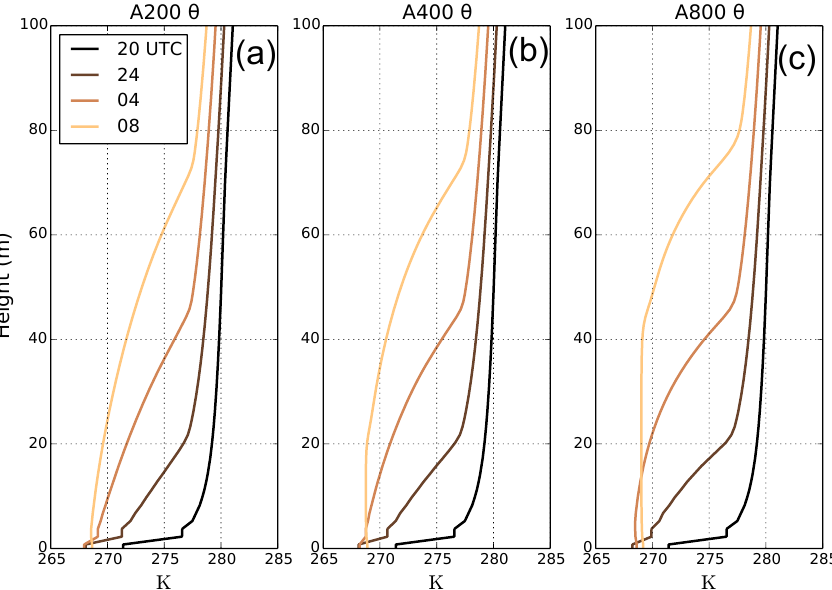
Figure 11. Domain mean profiles of potential temperature in 4h intervals starting from the formation of the fog layer (from black to orange) for the experiments (a) A200, (b) A400 and (c)